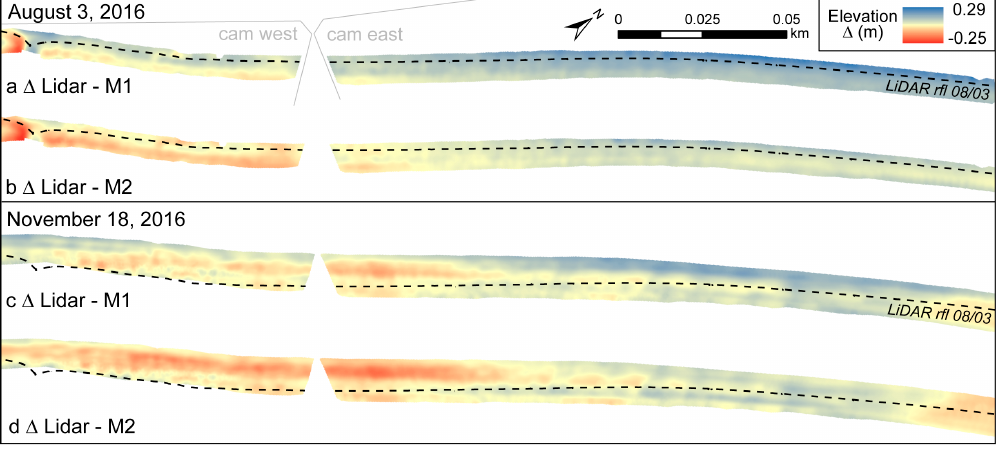
Figure 9. Overall differences between the LiDAR surveys and the video-based topography for 3 August ( a , b ) and 18 November ( c , d ). The 1.19 m rfl of 3 August as extracted from the LiDAR is shown on all figures.